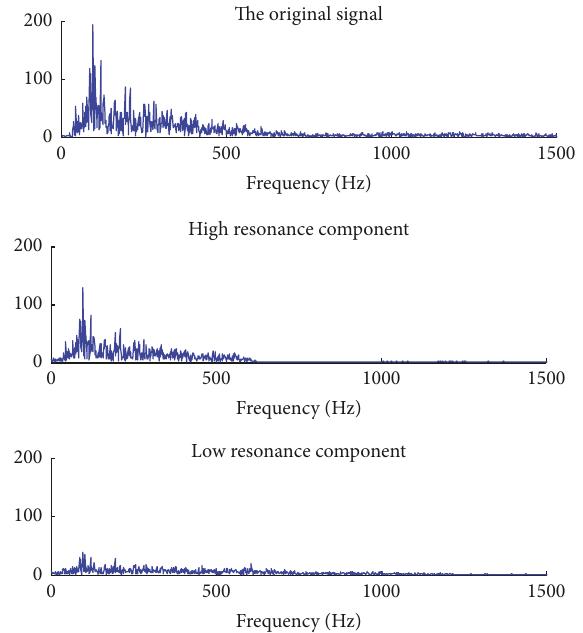
Figure 6: The spectrums of one ship radiated signal for noise A: the corresponding high and low resonance components.